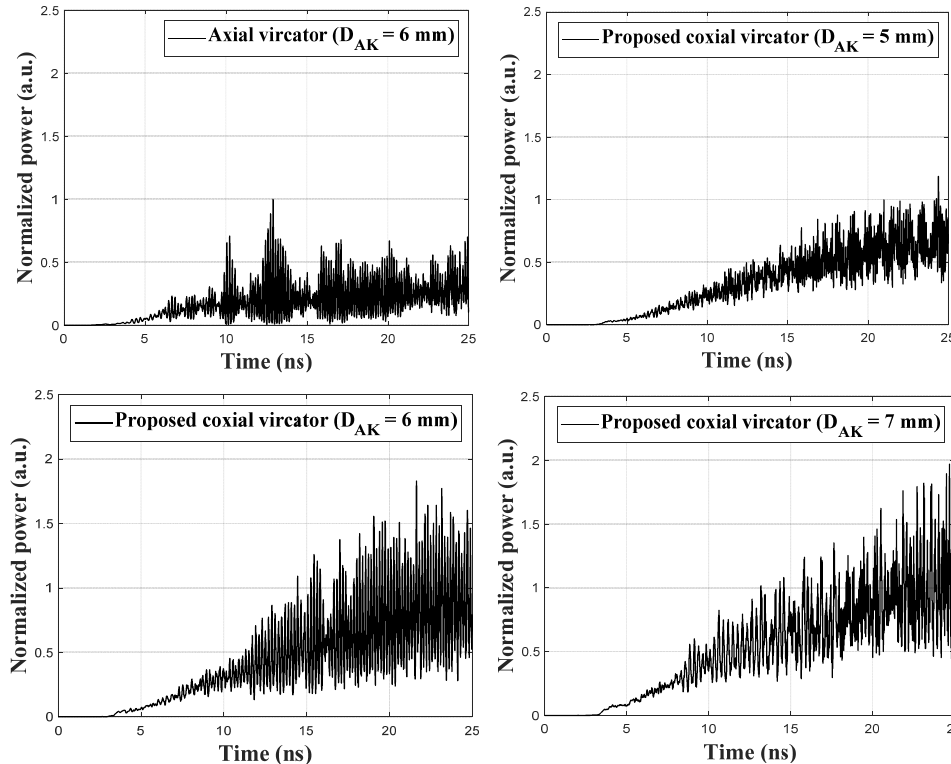
Figure 7. Normalized microwave power of the axial vircator and proposed coaxial vircator.